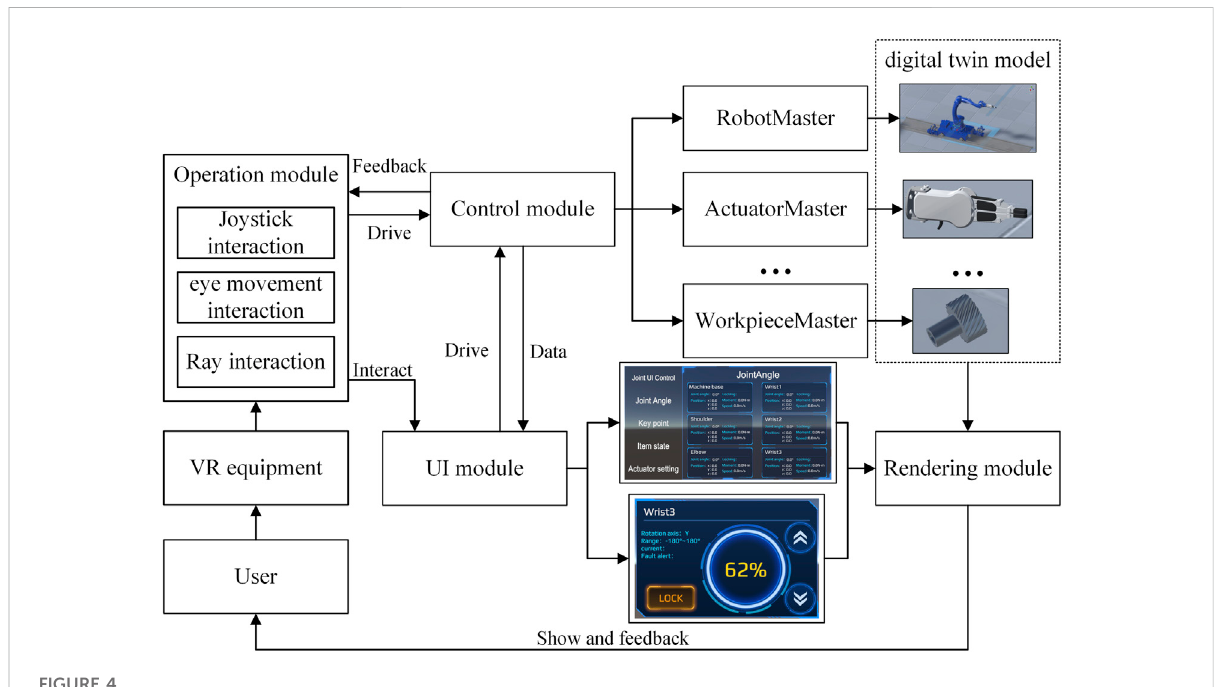
FIGURE 4 Teleoperating system